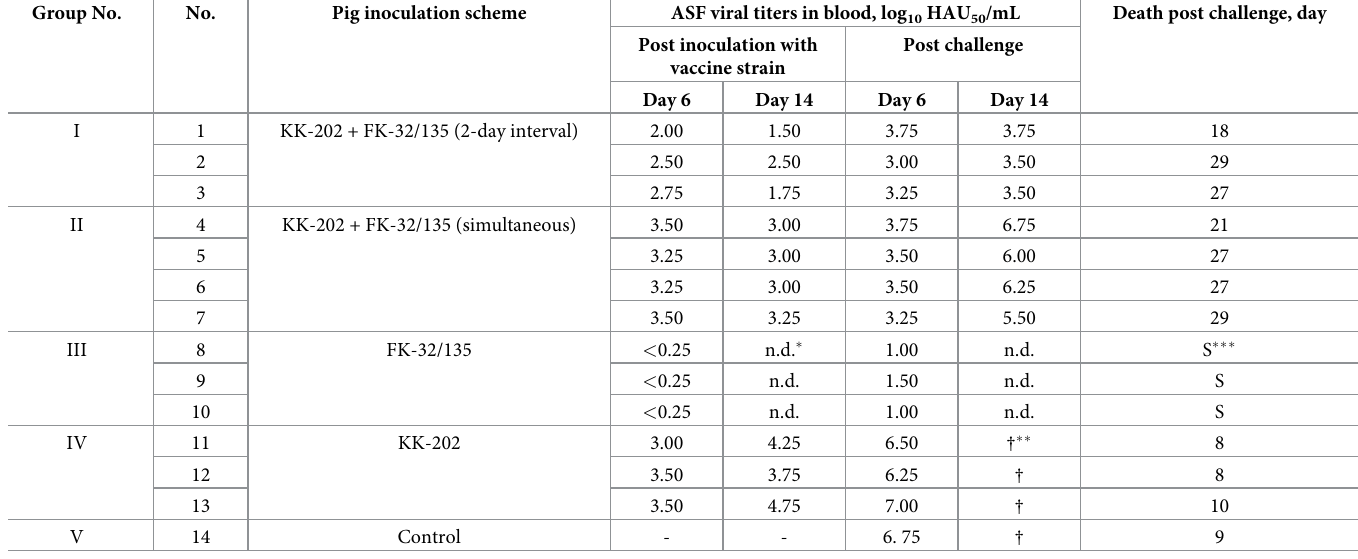
Table 1. The effect of inoculation of pigs in groups No. I–V with the attenuated ASFV strain KK-202 (seroimmunotype II) and/or vaccine strain FK-32/135 (seroim- munotype IV) on the subsequent challenge with the virulent strain France-32 (seroimmunotype IV). Group No. No. Pig inoculation